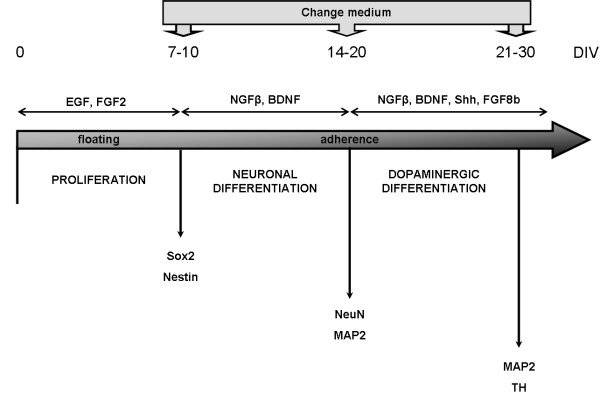
Strategy for neuronal dopaminergic differentiation of SVZ-derived progenitor cells. The scheme depicts the experimental approach to attain dopaminergic neurons from SVZ progenitors. Proliferation was conducted for 7–10 days in free-floating neurospheres, in the presence of EGF and FGF2. Neuronal differentiation was induced after adhesion to PLL- or nECM-coated coverslips in the presence of NGFβ and BDNF. Dopaminergic differentiation was observed after 35 days in neuronal differentiation conditions, in the presence of Shh and FGF8b. Immunofluorescence screening for different markers of neuronal differentiation (Sox2: 24 h; Nestin: 24 h and 7 DIV; NeuN: 14 DIV; TH: 21 DIV) was performed throughout the experiment with positivity arising at different days of differentiation as represented. DIV: days in vitro (in differentiation medium).